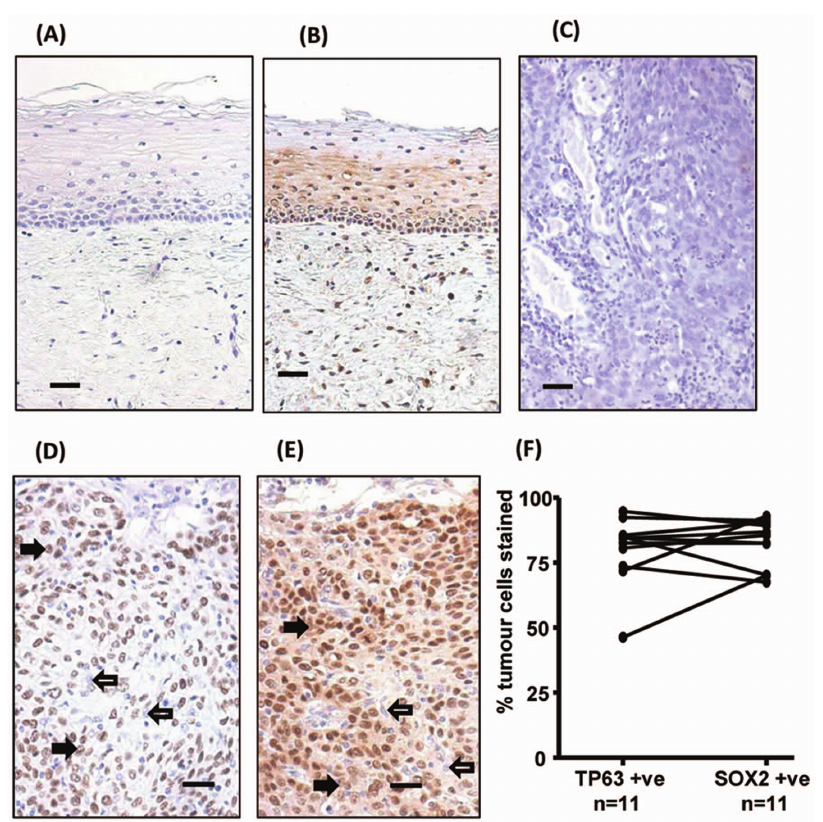
Fig. 6 TP63 and SOX2 staining in cervical biopsies. Immunohistochemical staining of cervical biopsies. Bars 5 50 m m.(A) normal cervix no primary control; (B) normal cervix stained with anti-SOX2; (C) Squamous cell cervical carcinoma no primary control; (D) representative TP63, and (E) representative SOX2, staining of tumour cells. For both TP63 and SOX2 staining was seen in the nucleus of positive cells (examples indicated by solid arrows); negative cells were a minority of tumour cells (examples indicated by unfilled arrows). (F) Image analysis results of % nuclear + ve tumour cells in biopsies. Parallel sections from 11 cases were stained with SOX2 and TP63. Tumour cells were evaluated for their nuclear expression of the transcription factors. There was no significant difference between the data for SOX2 and TP63 (Wilcoxon signed rank test).